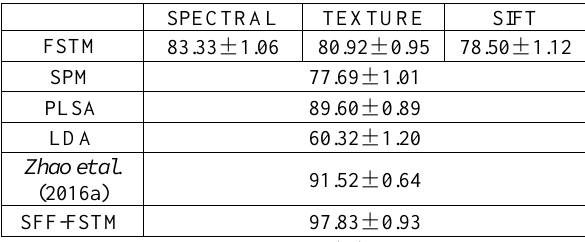
Table 4. Classification accuracies (%) of different strategies based on the FSTM and comparison with the experimental results of previous methods for the Google dataset of SIRI- WHU 3.4 Experiment 3: Multiple Semantic-feature Fusion Fully Sparse Topic Model for HSR Imagery with Limited Training